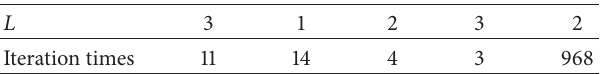
Table 3: Dynamic 𝐿 and the iteration times at the same 𝐿 value ( 𝑗 = 6 , 𝑇 = 0.1 , and 𝜏 = 0.0001